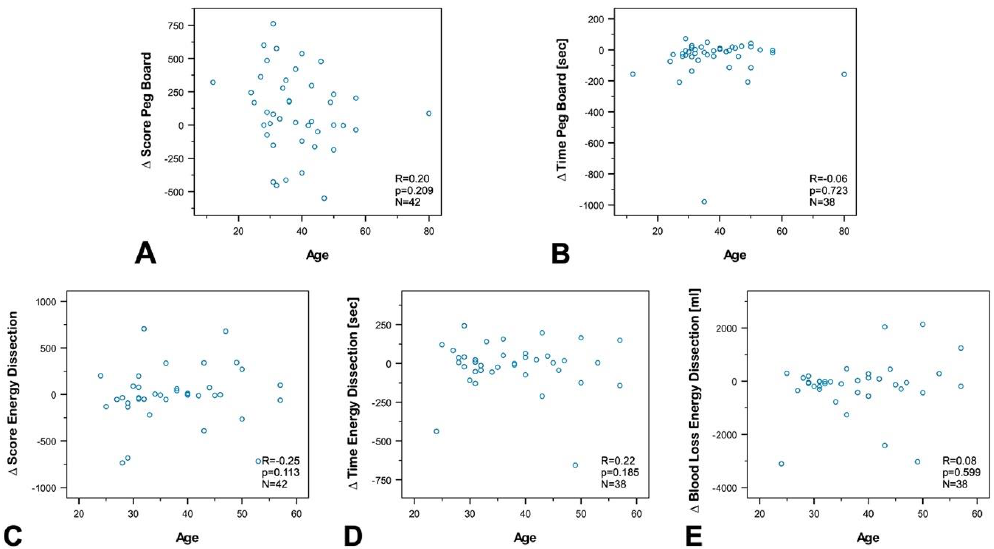
Figure 6. Correlation analysis between the age of the participants and ( A ) ∆ Final Score in Peg Board, ( B ) ∆ Time to complete Peg Board, ( C ) Final Score Energy Dissection, ( D ) ∆ Time to complete Energy Dissection, and ( E ) ∆ Blood Loss Energy Dissection. No significant correlation was found for any of the values (correlation coe ffi cient: R, statistical significance: p, number: